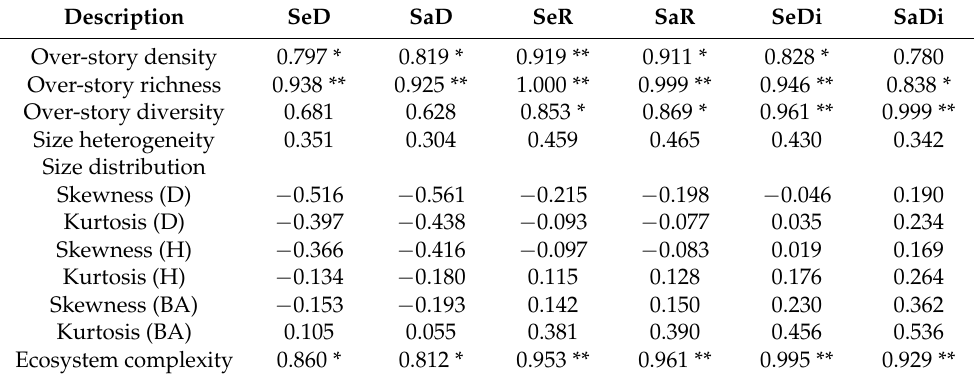
Table 9. The relationship between natural regeneration and overstory